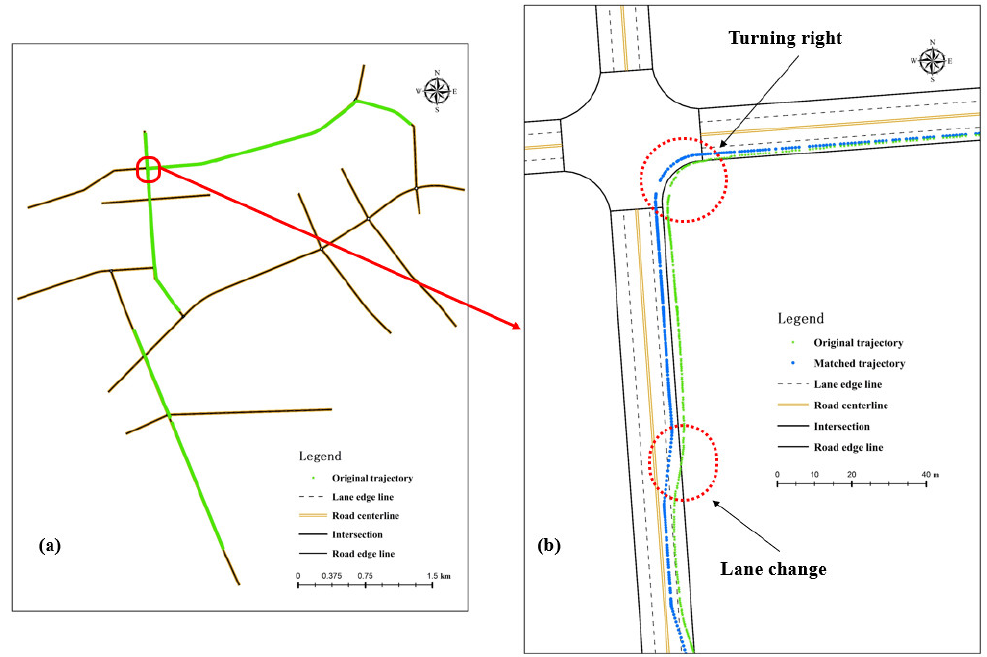
Figure 14. Trajectory matching results. ( a ) The tested road sections; ( b ) Lane-level map matching results.